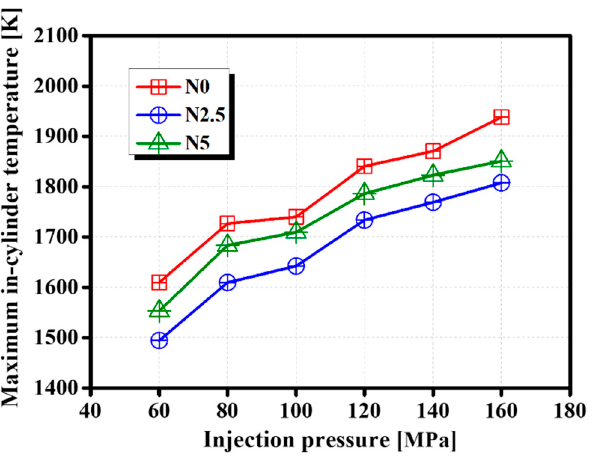
Figure 6. Variation in maximum in-cylinder temperature with injection pressure for n -octanol/diesel blends.